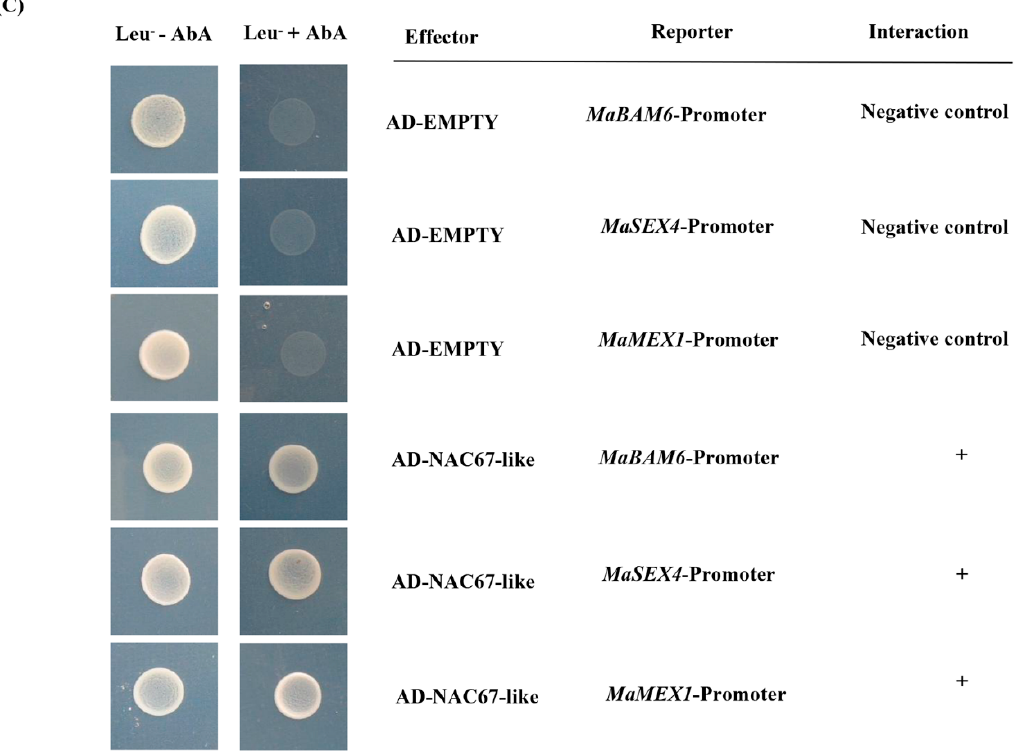
Figure 6. Y1H assay showing the ability of MaNAC67-like protein to bind promoters of MaBAM6 , MaSEX4, and MaMEX1 . ( A ) Diagram of the different constructs used in this experiment. ( B ) No basal expression of MaBAM6 , MaSEX4, or MaMEX1 promoters was observed in yeast grown on SD medium lacking Leu with 200 ng mL − 1 AbA. ( C ) Yeast growth assays for determining the binding ability of MaNAC67-like to promoters of genes related to starch degradation. MaNAC67-like effector or empty (AD, negative control) plasmids were transformed into Y1H reporter strains. The interaction was assessed according to the growth condition of transformed yeast on SD medium lacking Leu but with AbA.